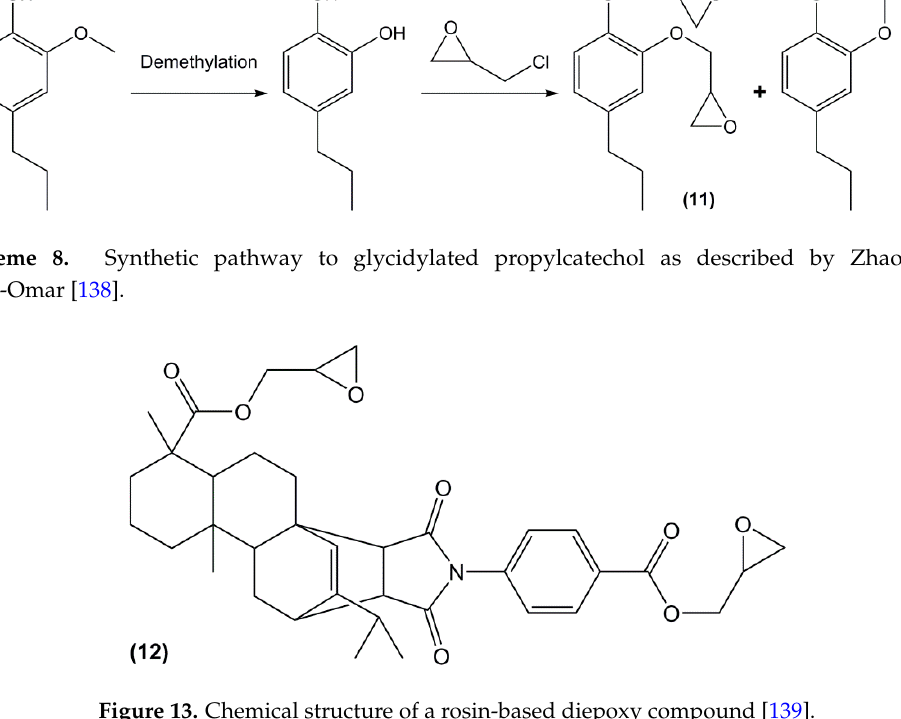
Figure 13. Chemical structure of a rosin-based diepoxy compound [139].